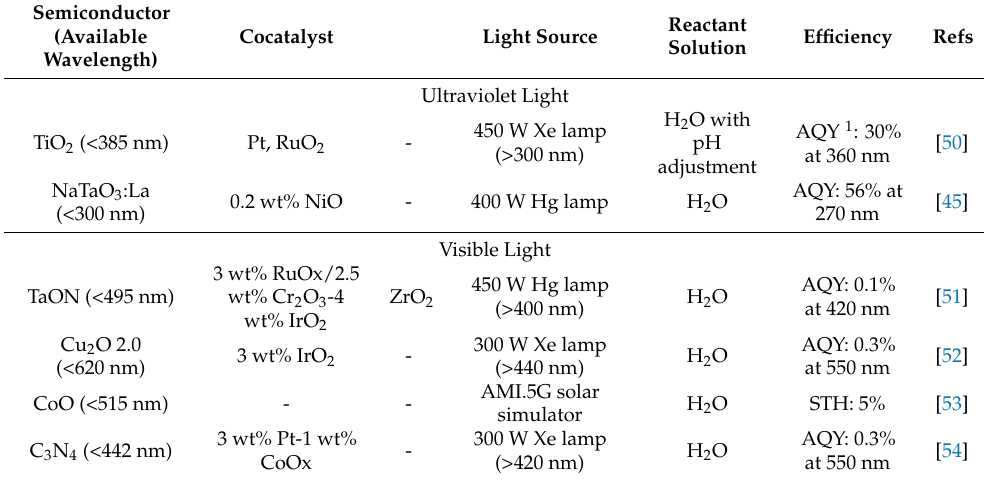
Table 2. List of recent one-step photochemical water-splitting